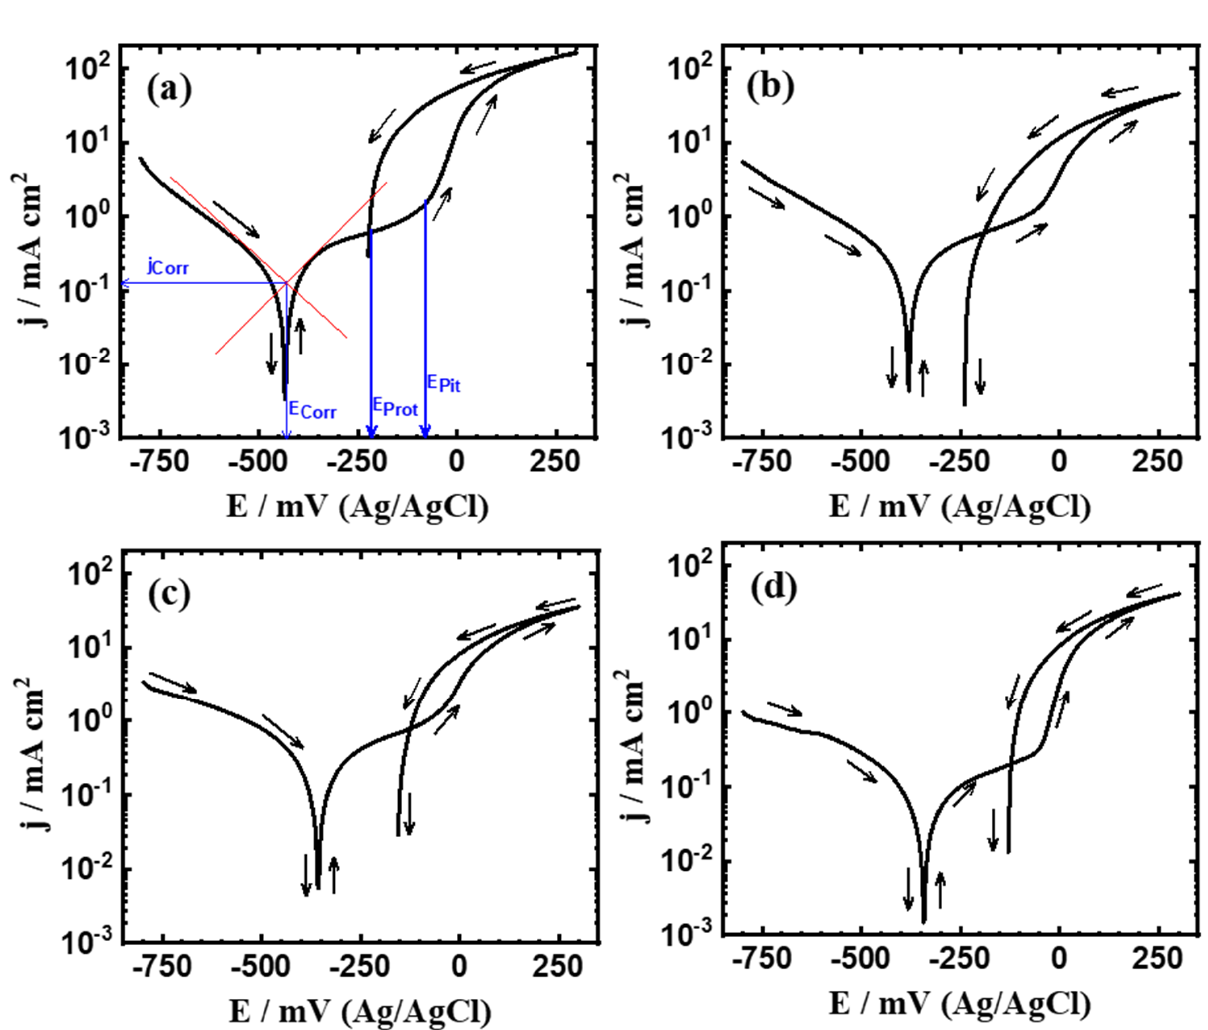
Figure 10. Cyclic potentiodynamic polarization (CPP) curves of fabricated ODS-HECs for ( a ) CrFeCuMnNi; ( b ) CrFeCuMnNi-3 vol.% Al 2 O 3 ; ( c ) CrFeCuMnNi-3 vol.% Y 2 O 3 ; and ( d ) CrFeCuMnNi-3 vol.% TiO 2 .